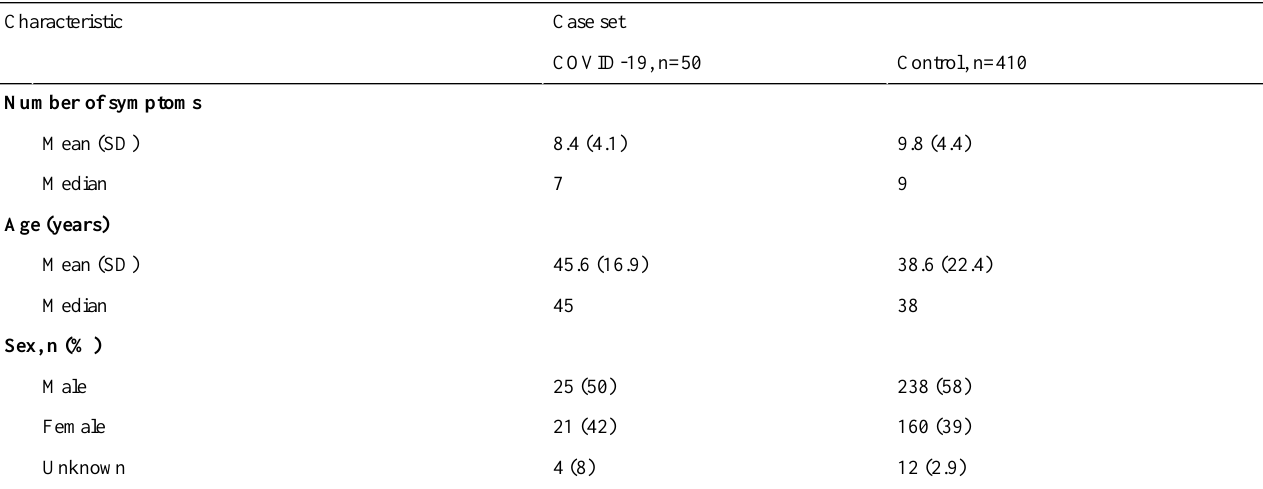
Table 2. Number of symptoms and age and sex distributions in each case set (N=460).